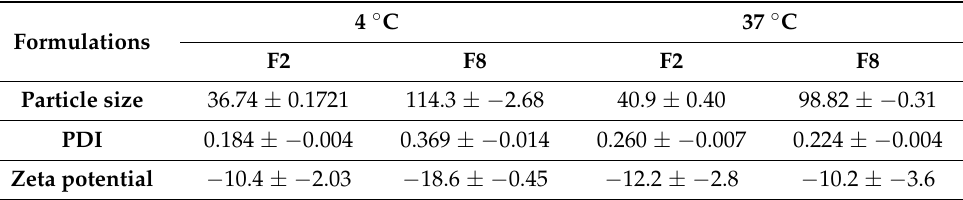
Table 7. Mean particle size, PDI, and zeta potential values of the PF-loaded SNEDDS formulations after 3 months of storage at 4 ◦ C and 37 ◦ C, respectively.